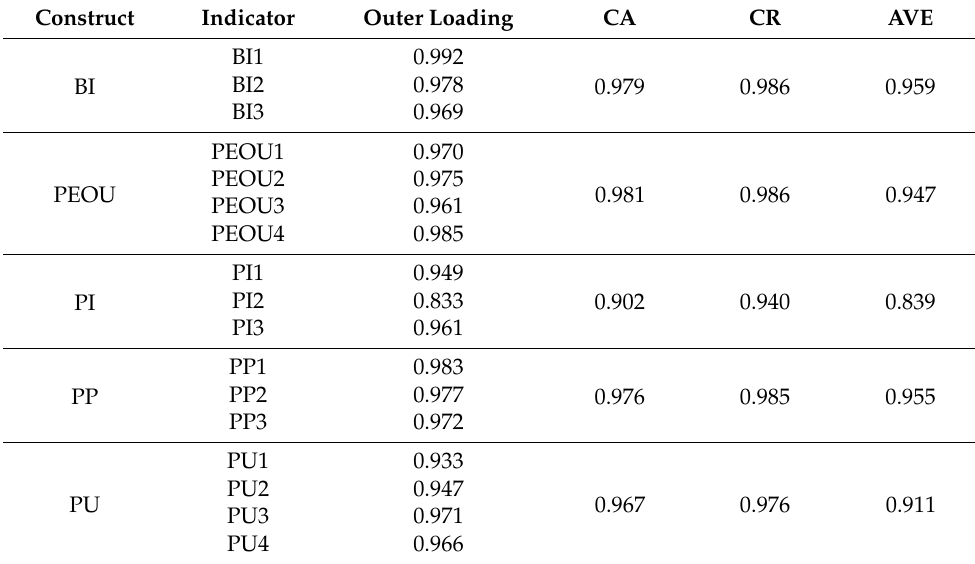
Table 4. Measurement model’s reliability and convergent validity.